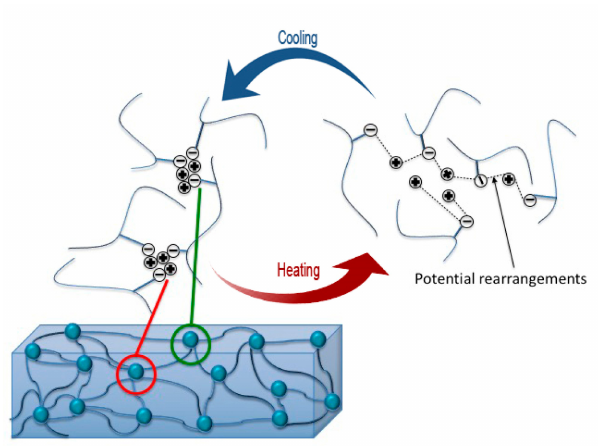
Figure 1. Ionomer structure with a focus on the ionic aggregate clusters that are tightly packed on the left-hand side. Upon heating, they have a larger margin for movement and can form new thermally reversible